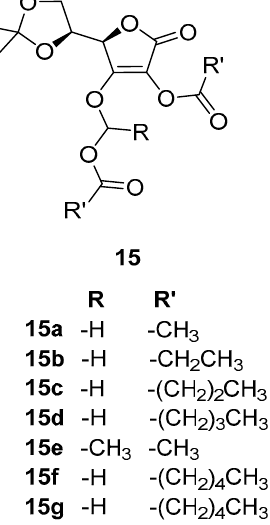
Figure 5. 2- O -acyl-3- O -(1-acyloxyalkyl) derivatives of VCA, 15a – g .